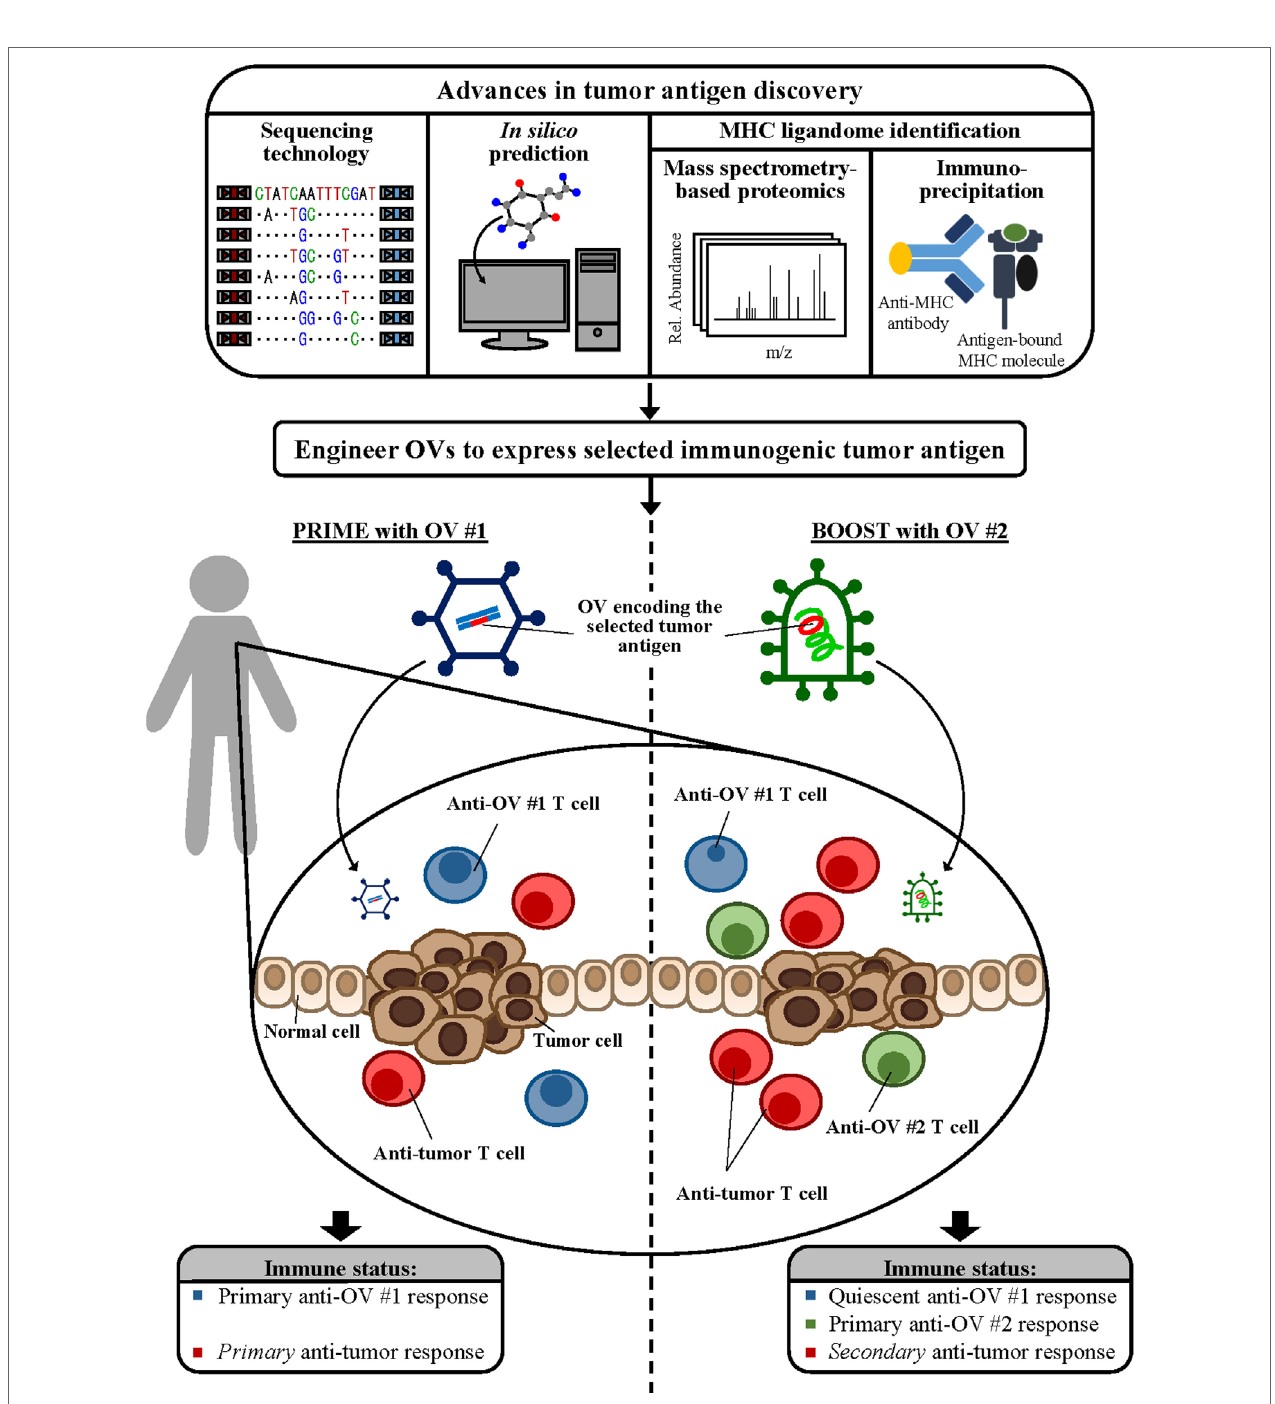
FiGURe 1 | Combining novel antigen discovery platforms to design oncolytic vaccines. Advances in sequencing technology, in silico prediction methods, and mass spectrometry-based proteomics and immunoprecipitation for major histocompatibility complex (MHC) ligandome elucidation allow identification of novel tumor antigen targets. Engineering these novel antigens into powerful viral vectors will provide a platform for the development of the next generation of oncolytic vaccines. Incorporating immunomodulatory strategies, such as the heterologous virus prime-boost as shown, during oncolytic vaccine administration can maximize antitumor immune responses, leading to the development of complete and clinically efficacious antitumor treatment